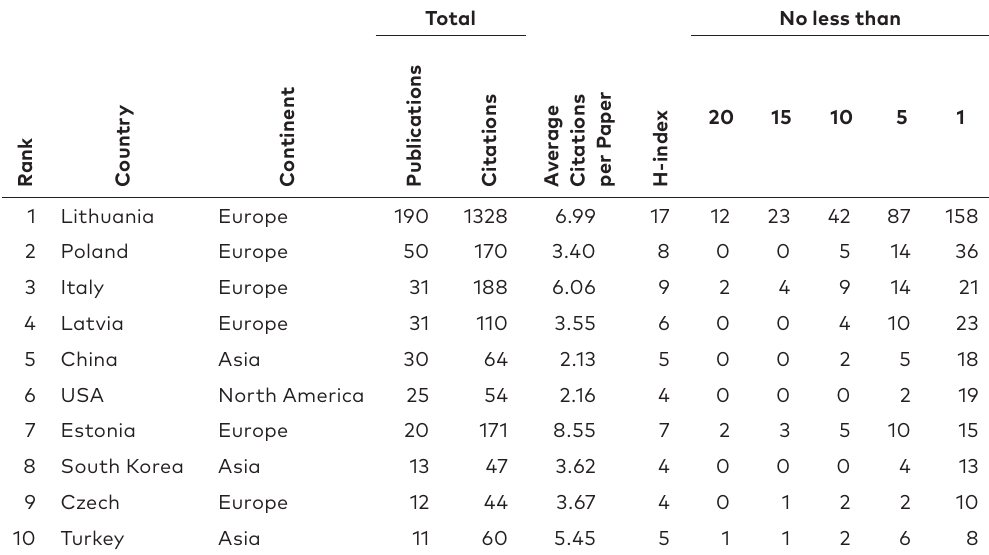
Table 5. The ten most influential countries of the Baltic Journal of Road and Bridge Engineering publications